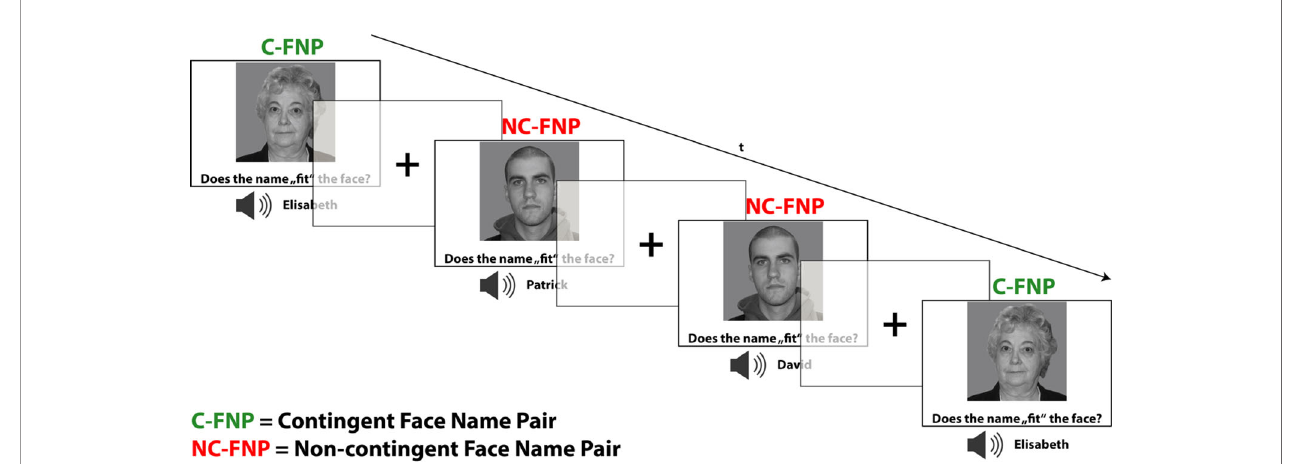
FIGURE 1 | fMRI paradigm for memory encoding: implicit contingency learning task. Subjects rated the subjective fi t of face – name pairs without instruction of learning. Half of the faces were presented in fi xed, contingent combinations/face – name pairs (C-FNP), half were presented in varying, non-contingent combinations (NC-FNP). Duration of stimulus presentation was 2,800 ms. Trials were separated by a fi xation cross with jittering ranging from 500 to 900 ms. The depicted faces were taken from the life span database of adult facial stimuli (27,